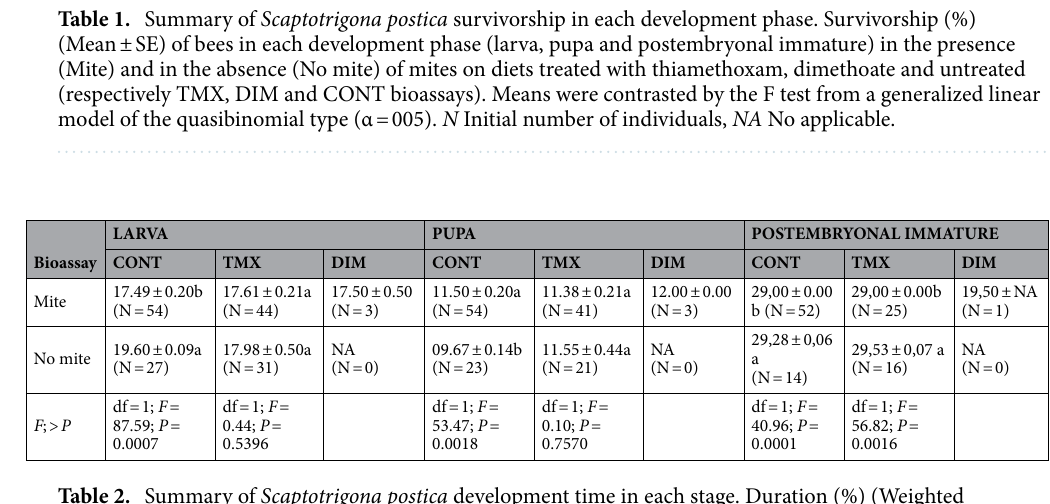
Table 2. Summary of Scaptotrigona postica development time in each stage. Duration (%) (Weighted Mean ± SE) of each development phase (larva, pupa and newly emerged) in the presence (Mite) and in the absence (No mite) of mites and exposed to thiamethoxam (TMX) and dimethoate (DIM) and the control group (CONT). Averages followed by the same letters do not differ by t test (LSD—significant minimum difference) with Bonferroni protection (α = 0,05). N Number of individuals analysed, NA No